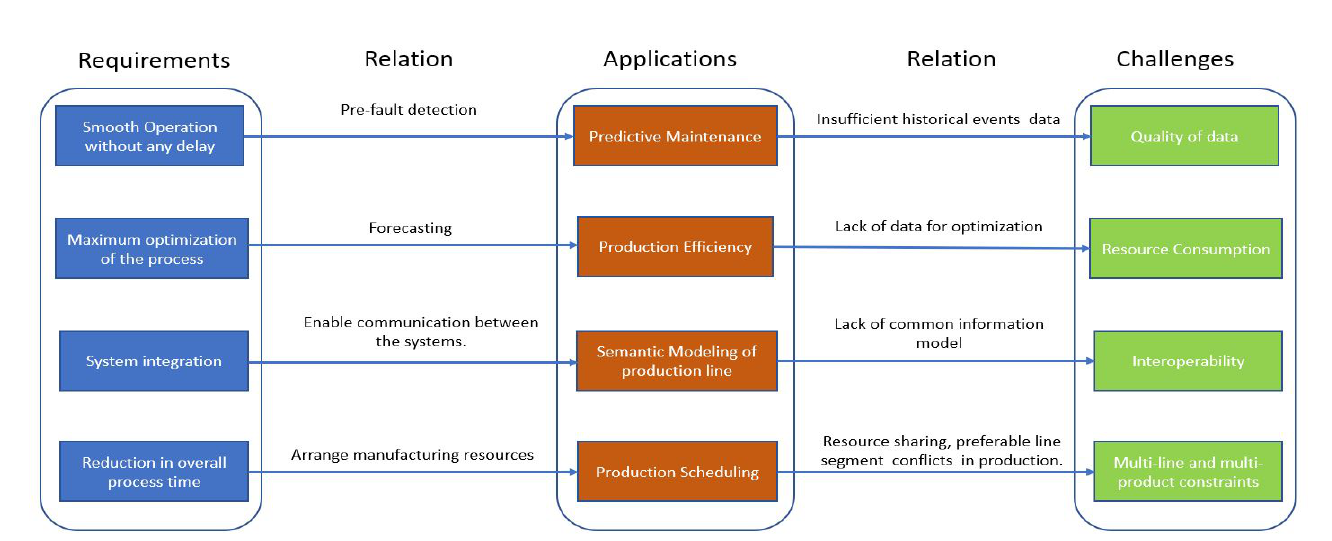
Figure 4. One to one mapping between requirements, applications, and